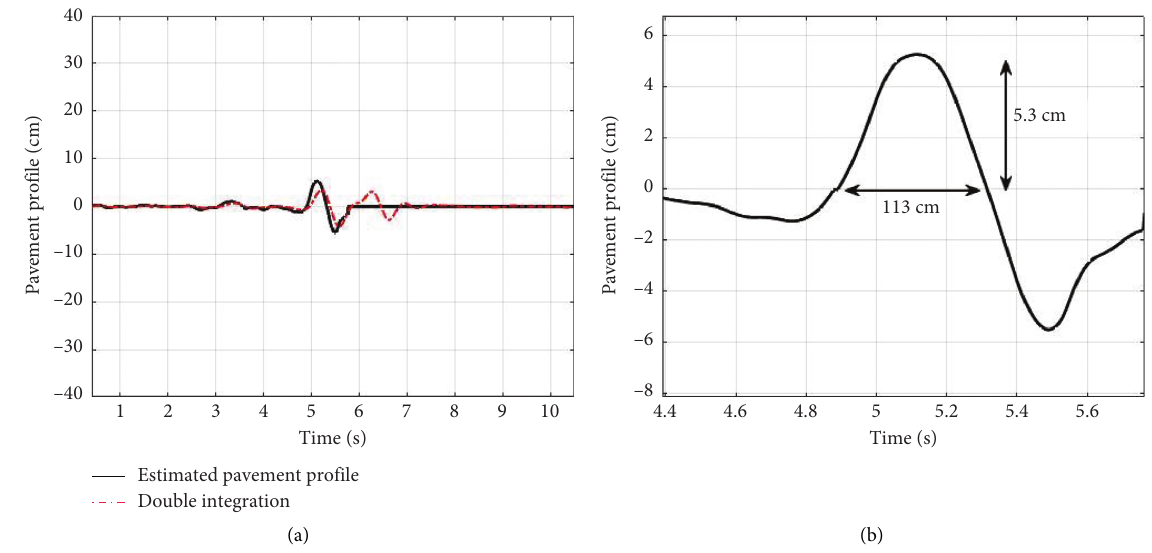
Figure 13: Pavement profile estimation for the speedbump. (a) The estimated pavement profile versus double integration (speedbump). (b) The estimated geometry